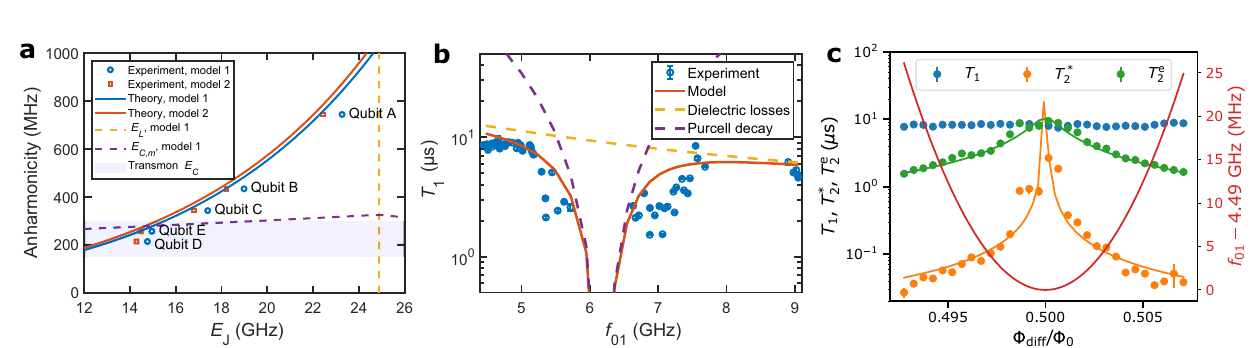
Fig. 3 | Measurement of key qubit properties. a Predicted (solid lines) and measured anharmonicities of fi ve unimon qubits (markers) at fl ux bias Φ diff = Φ 0 /2 asfunctionsof theJosephsonenergy E J estimatedfromdatasimilartoFig.2cusing themodels1(bluecolor)and2(orangecolor)presentedin “ Methods ” .Thedashed yellow line highlights the E J that perfectly cancels the linear inductive energy in model1.Thecapacitivequbitenergy E C , m inmodel1followsthedashedpurpleline, whereas the purple shading visualizes typical transmon anharmonicities. b Experimentallymeasuredmeanenergyrelaxationtime T 1 ofqubitB(bluecircles) asafunctionofthequbitfrequency f 01 togetherwithamodel(solidline)takinginto accountdielectriclosses(dashedyellowline)andthePurcelldecay(dashedpurple